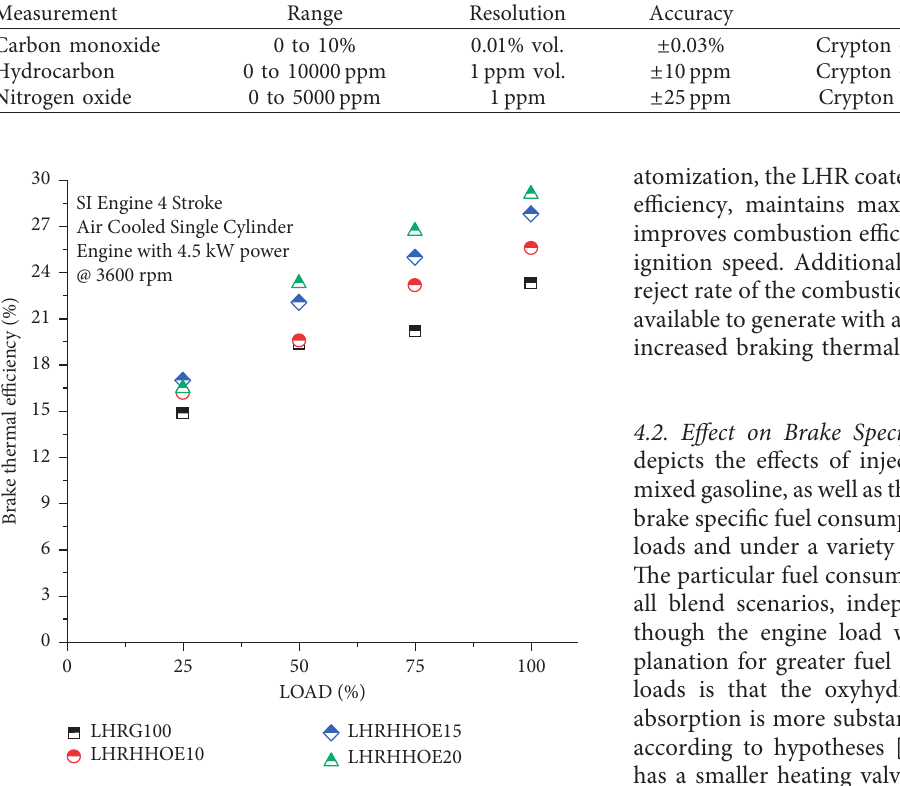
Figure 2: Study on brake thermal efficiency on nanocoated eth- anol-gasoline